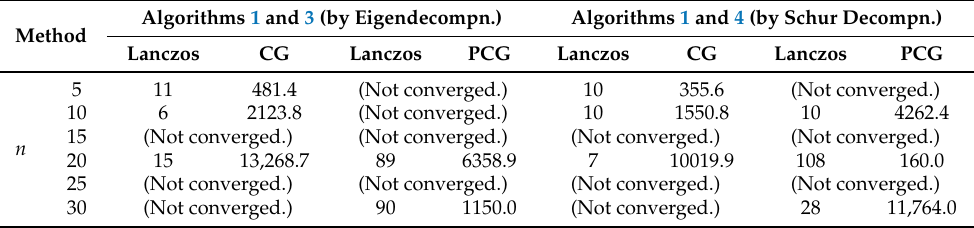
Table 10. Number of iterations of the Lanczos method and the average of numbers of iterations of the CG/PCG method in the case of the 5-th min. singular value of marginally symmetric matrix T with a = c = 1 and b = 0.2 in (9) for the shift (8). Algorithms 1 and 3 (by Eigendecompn.) Algorithms 1 and 4 (by Schur Method